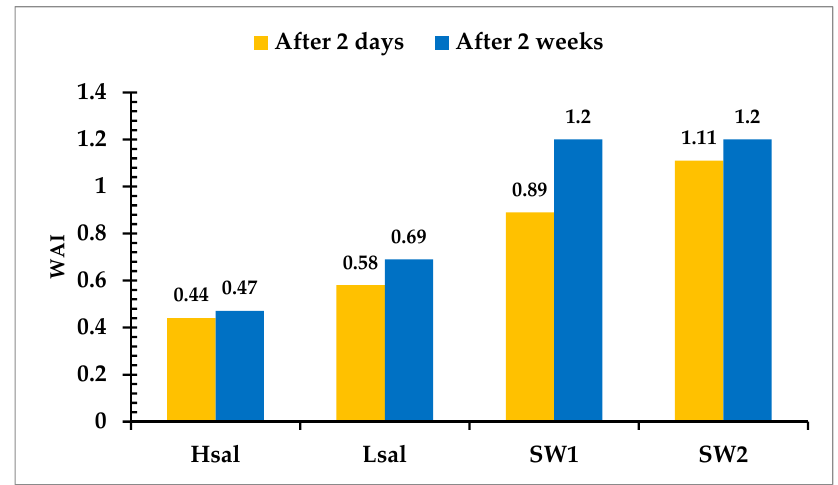
Figure 9. Wettability Alteration Index for Case 4 (oil wet) calcite surface treated with different brines.